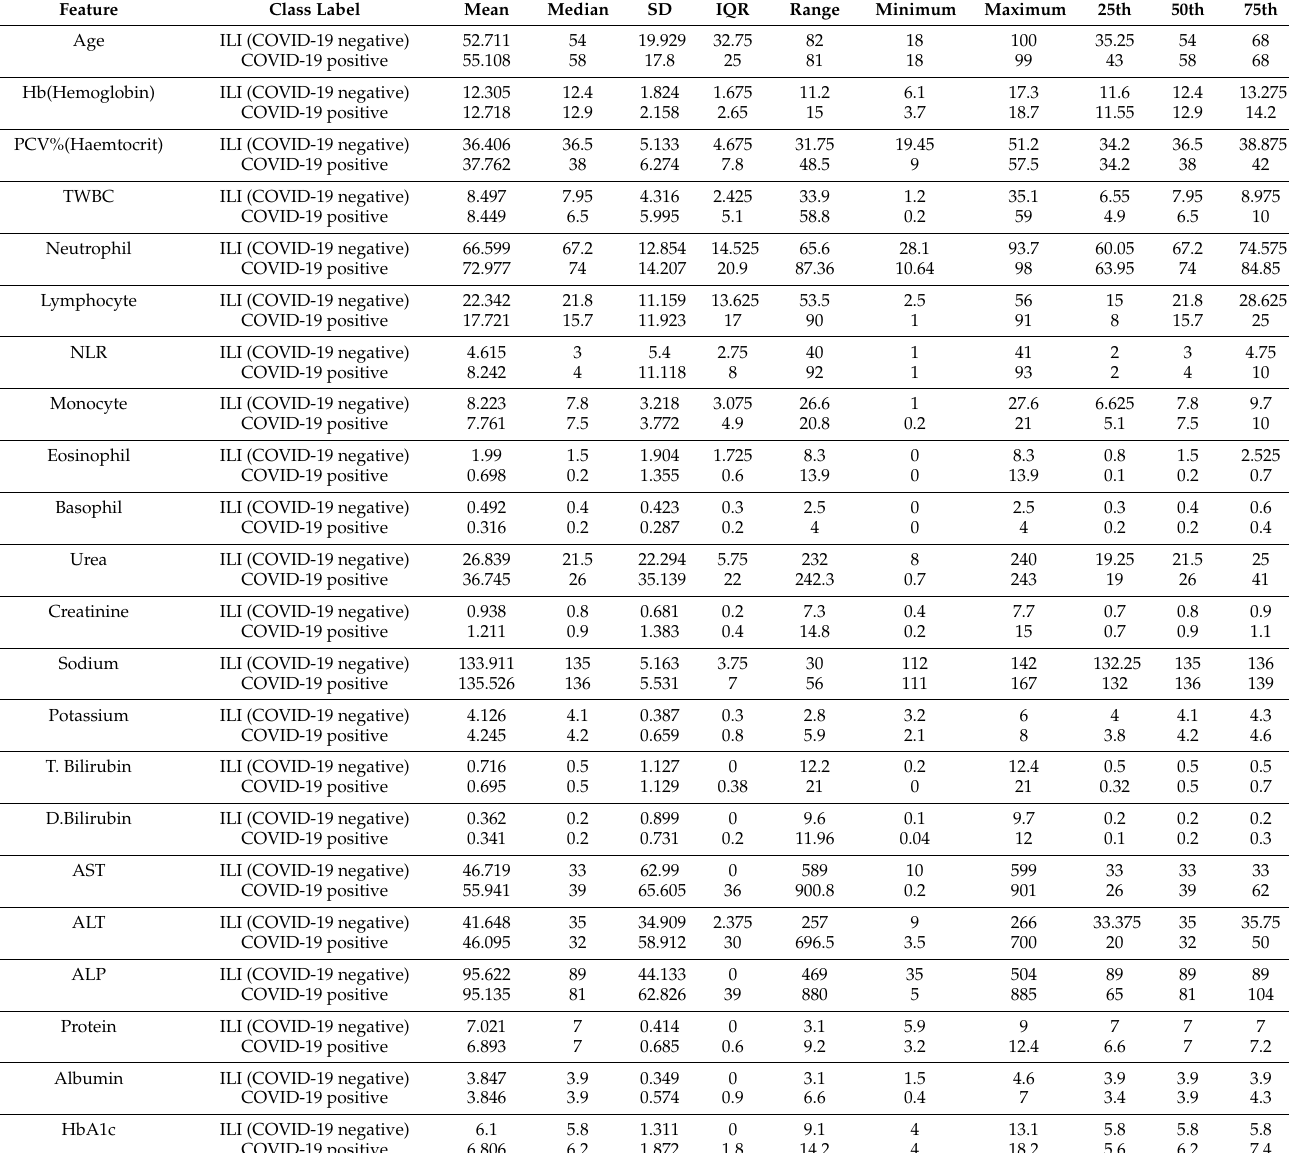
Table 2. Descriptive statistics of the COVID-19 data